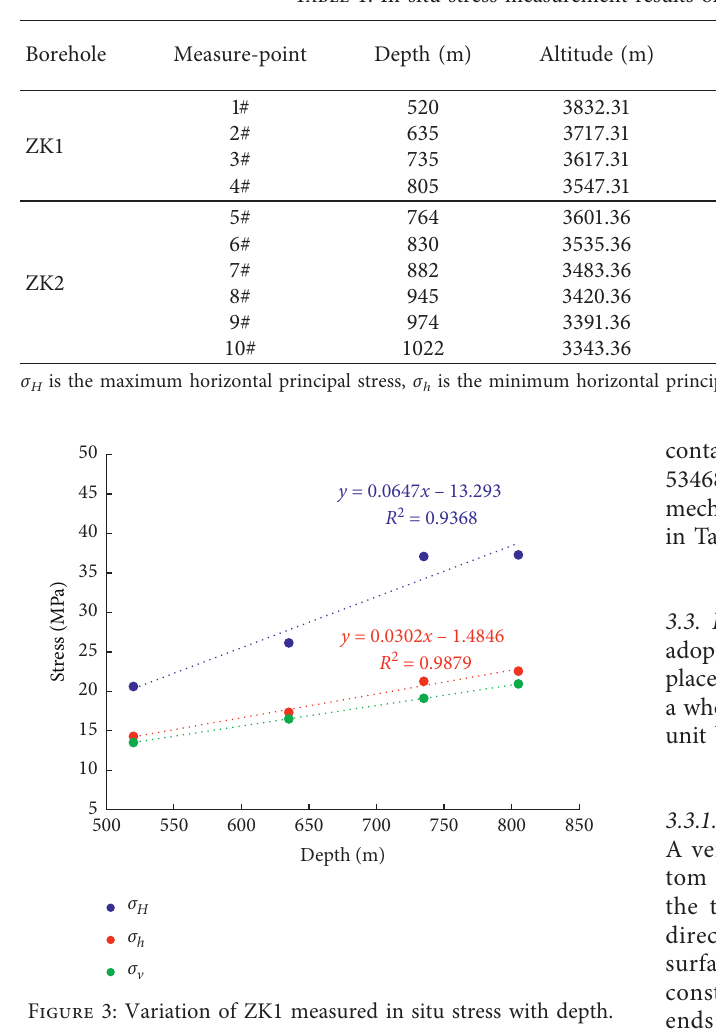
Table 1: In situ stress measurement results of hydraulic fracturing method.